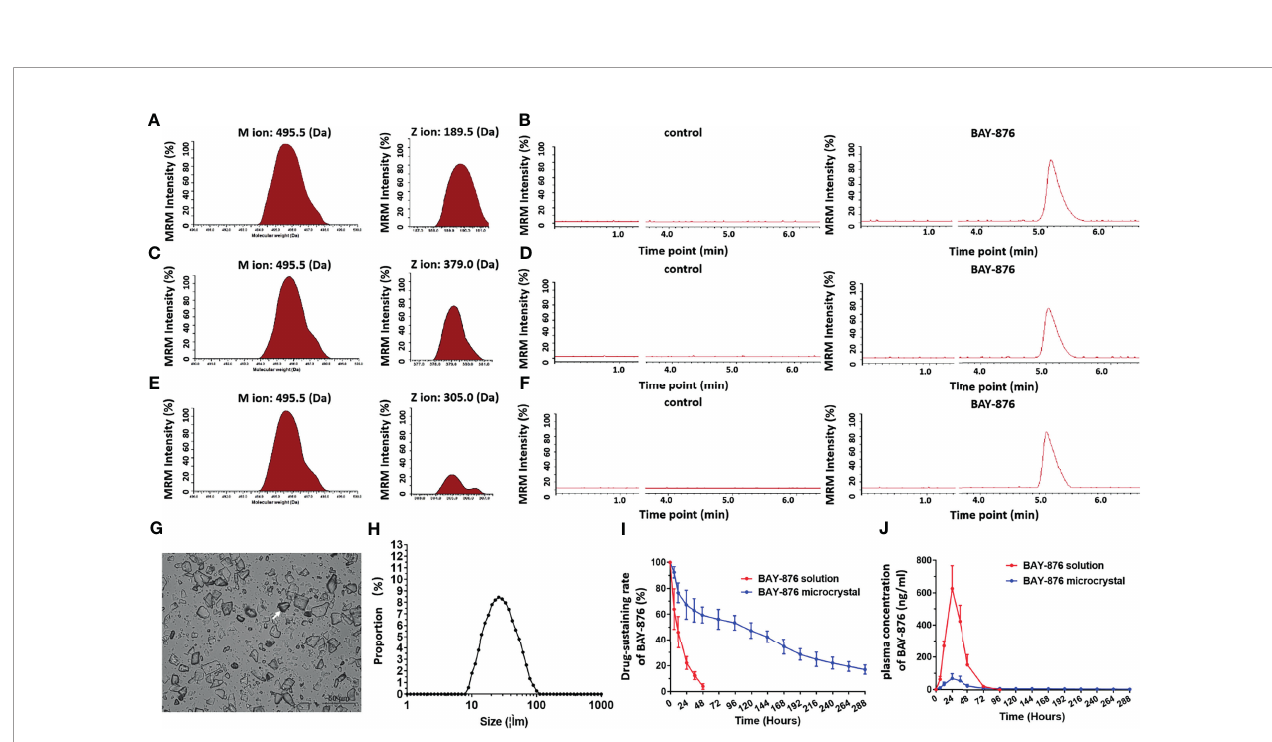
FIGURE 4 | BAY-876 microcrystalline achieved long-sustaining release of BAY-876 in HCC tissues. (A – F) LC-MS/MS approach for the detection of BAY-876. (G) Images of BAY-876 microcrystalline structure. (H) Particle size distribution of Bay-876 microcrystalline. (I) In vivo drug-release rate curve of BAY-876 in HCC subcutaneous tumor tissues. (J) Blood concentration curve of BAY-876 in HCC subcutaneous tumor tissues injected with microcrystalline BAY-876.